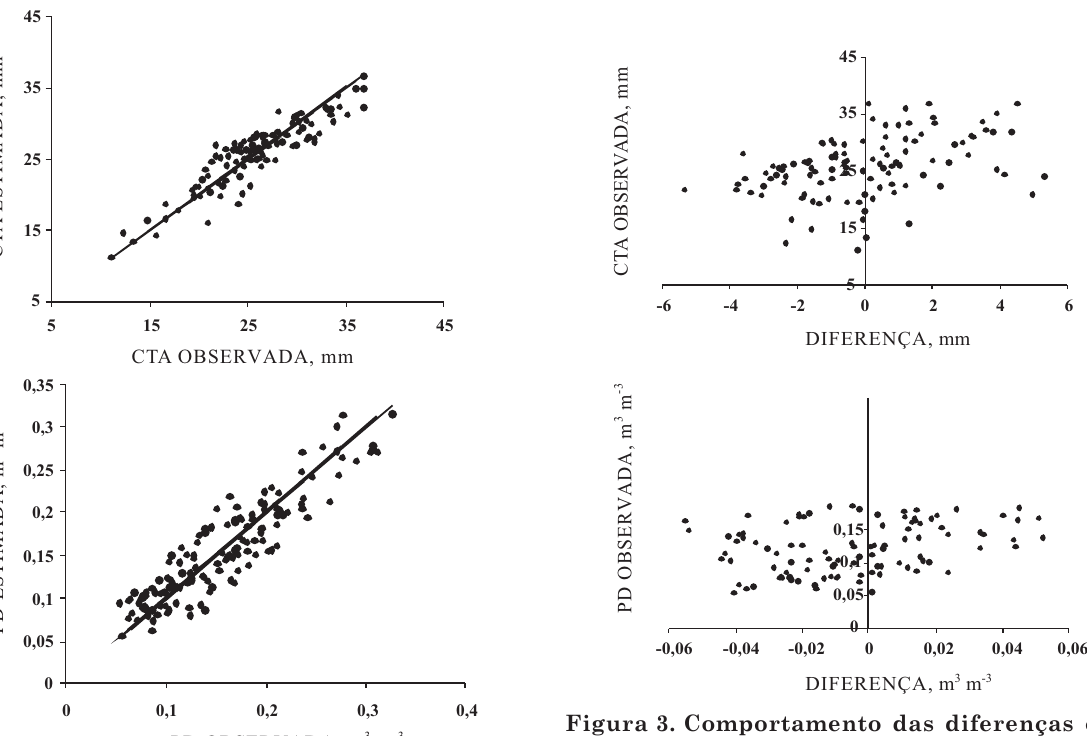
Figura 3. Comportamento das diferenças entre valores observados e estimados pelos modelos para CTA e PD para os solos da bacia hidrográfica do Ribeirão